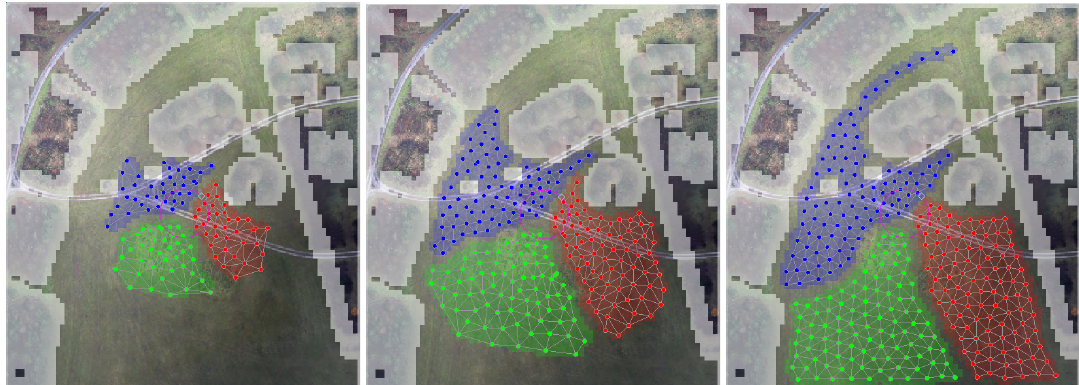
Figure 3. Three snapshots of the map discretization algorithm for partitioning the ROI into three regions (red, blue, green). The green circumference delimits the drones starting position. Obstacles are marked in